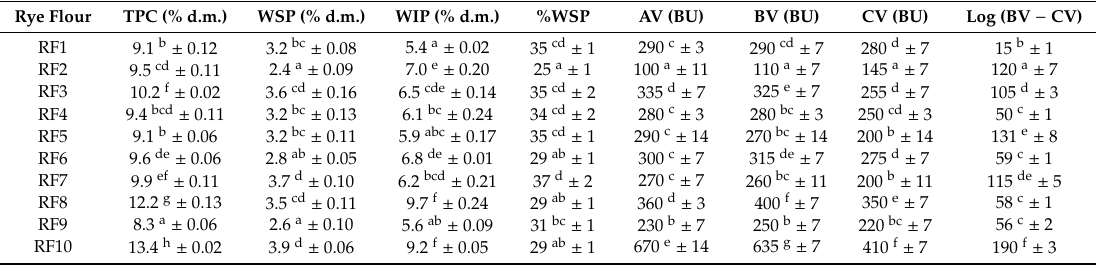
Table 2. The content of pentosans in tested rye flours and parameters of the swelling curves. Rye Flour TPC (% d.m.) WSP (%